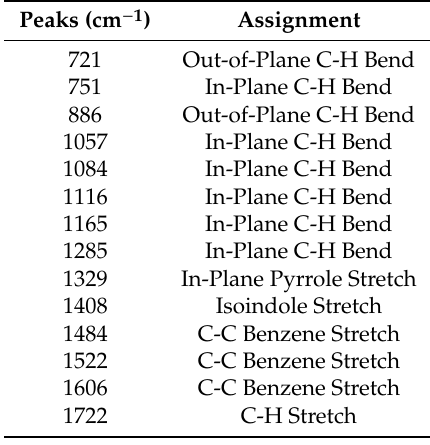
Table 2. Assignments of the Main FTIR Bands for ZnPc thin